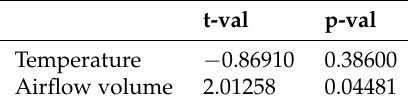
Table 5. Test between small and large